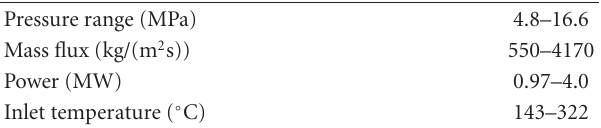
Table 6: Boundary conditions for steady state bundle void fraction tests.